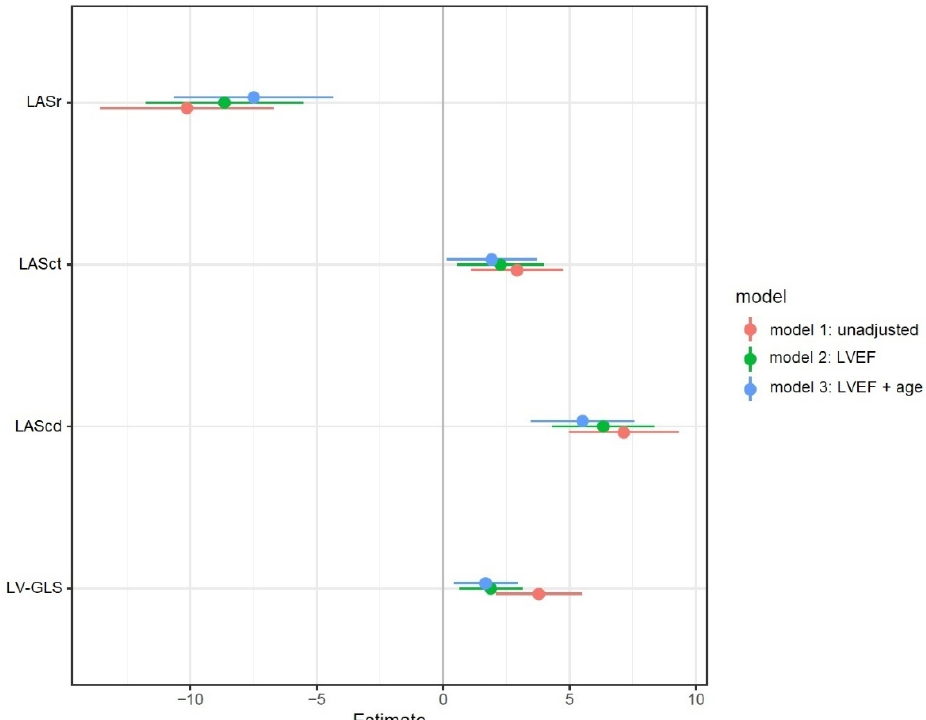
Figure 4. Estimated differences in strain values between patients with and without COPD (strain value of COPD patients—strain value of non-COPD patients). Positive estimates indicate larger (more positive or less negative) values among COPD patients. Model 1: unadjusted; model 2: adjusted for LVEF (%); model 3: adjusted for LVEF (%) and age (years). Abbreviations: COPD, chronic obstructive pulmonary disease; LAScd, left atrial strain during conduit phase; LASct, left atrial strain during contraction phase; LASr, left atrial strain during reservoir phase; LVEF, left ventricular ejection fraction; LV-GLS, left ventricular global longitudinal strain.